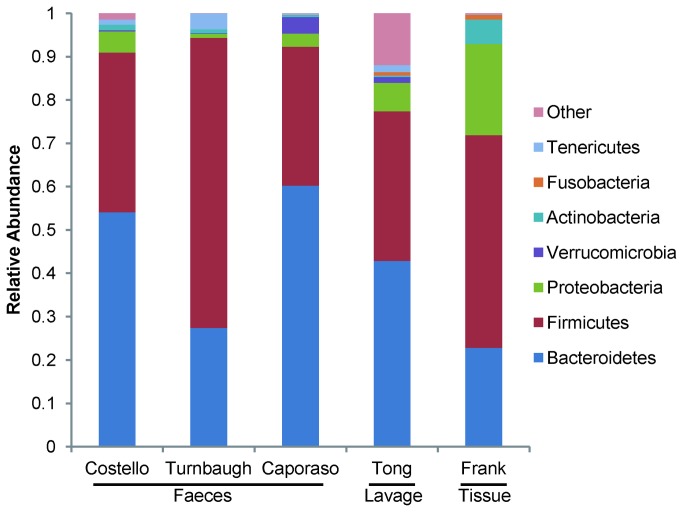
Phylum level microbial compositions of faeces, lavage and tissue samples.Biospeciemens from faeces (Costello [45], Turnbaugh [12] and Caporaso [11]), lavage samples (Tong) and tissue samples (Frank [21]) were compared. Only predominant phyla with relative abundances higher than 0.1% in Tong dataset were depicted in the bar graph, and the phyla with low abundances were grouped together. For Costello and Caporaso datasets, only the fractions of intestinal microbiota were shown here.